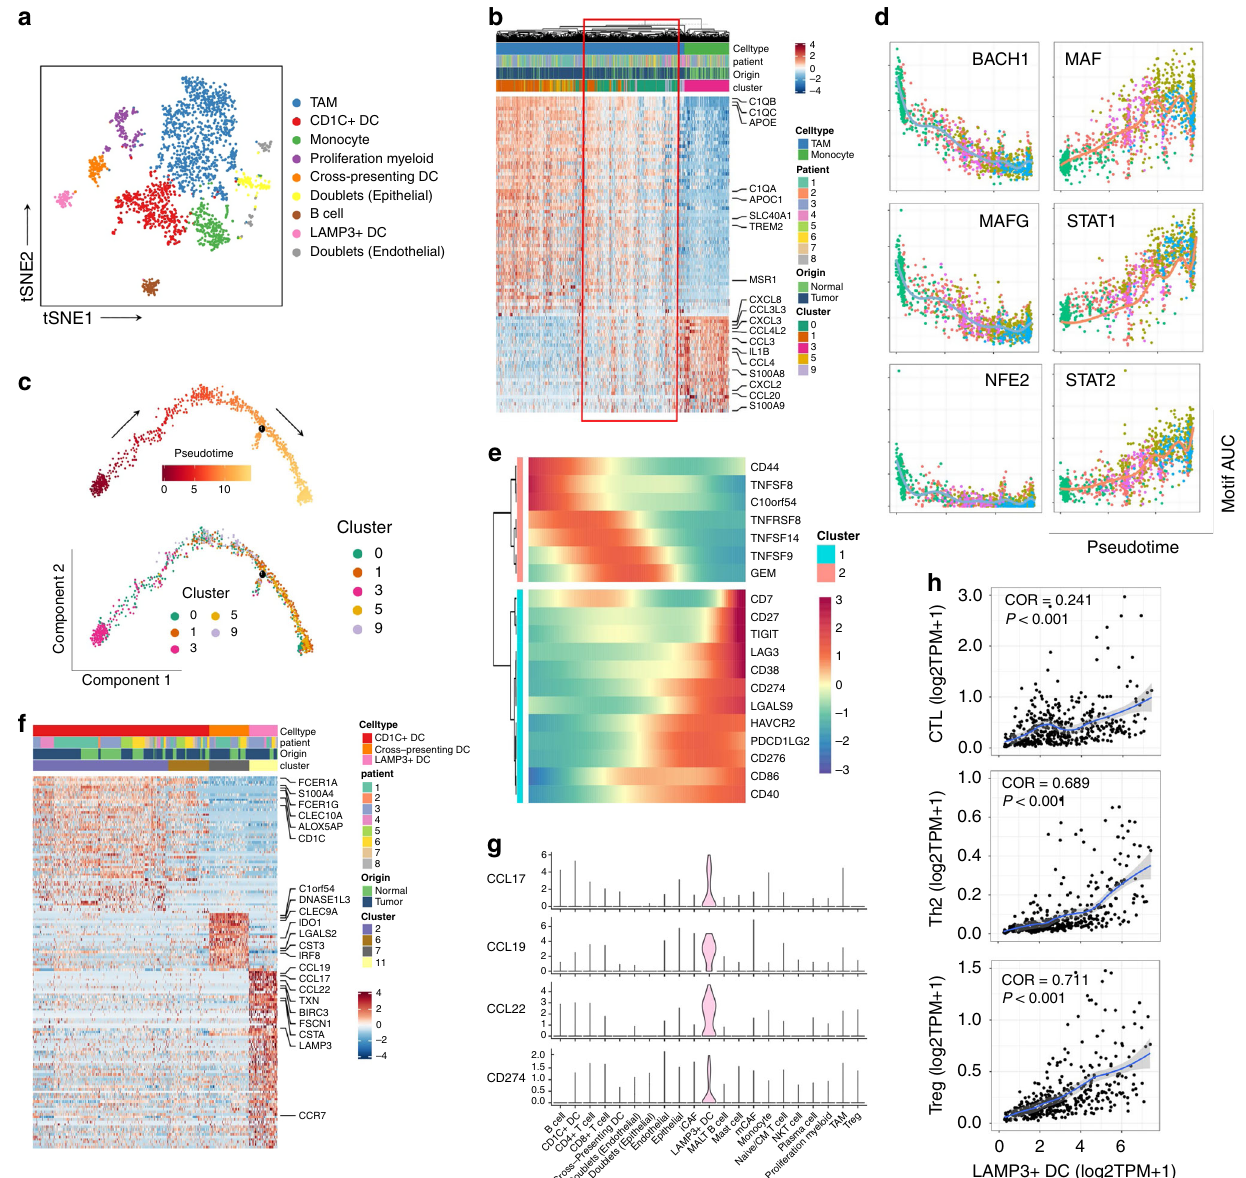
Fig. 2 Reclustering of myeloid-derived cells (LYZ + ). a tSNE plot of subgroups of LYZ + single cells. b DEGs between monocytes and TAMs. Single cells in red blank show features of both groups. c Trajectory of differentiation from monocyte into TAMs predicted by monocle 2. d Signi fi cantly inhibited or activated TF motifs in the differentiation process colored by cell clusters. e Heatmap show upregulated or downregulated immune checkpoints in the differentiation process. f Heatmap of DEGs between three different DC subgroups. g Violin plot show expression level of cytokines and CD274 highly expressed in LAMP3 + DCs. h Correlation between LAMP3 + DCs and different T cell subgroups in TCGA BLCA cohort. Coef fi cient was calculated with spearman correlation